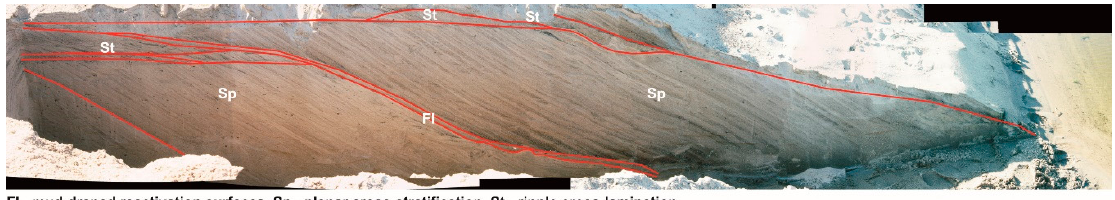
Figure 6. Sedimentary structures-Byzie bar head 19 October 2012.